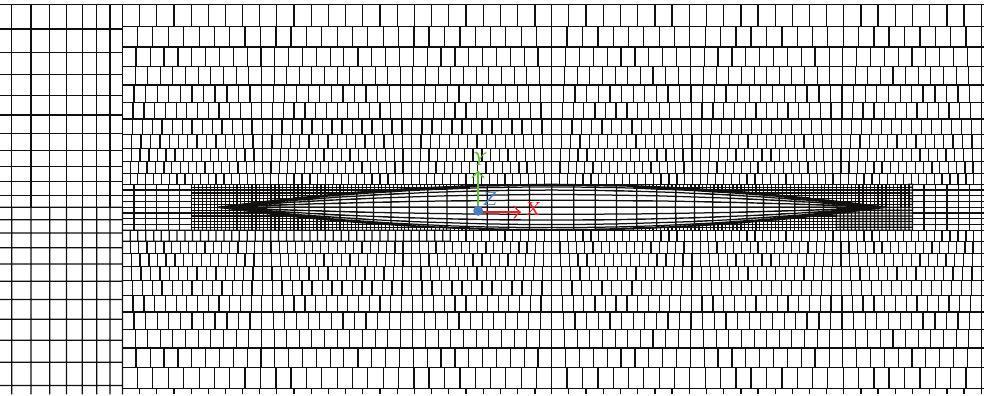
Figure 3: Example of free-surface panelization when using Chimera grid